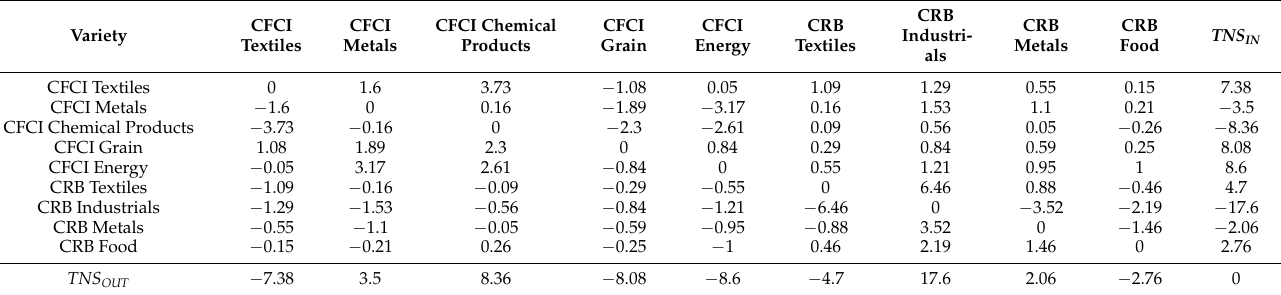
Table 3. Net volatility spillover matrix between